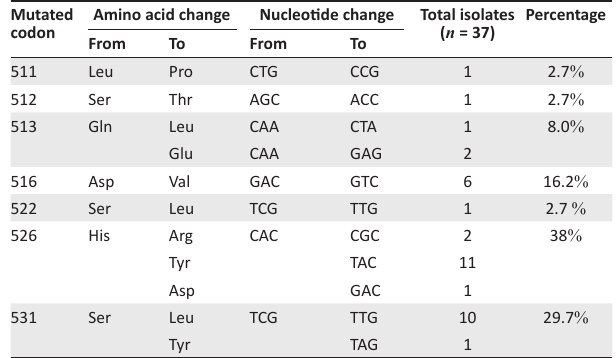
FIGURE 1: Workflow and isolate selection for DNA sequencing from tuberculosis cultures and processed sediments.